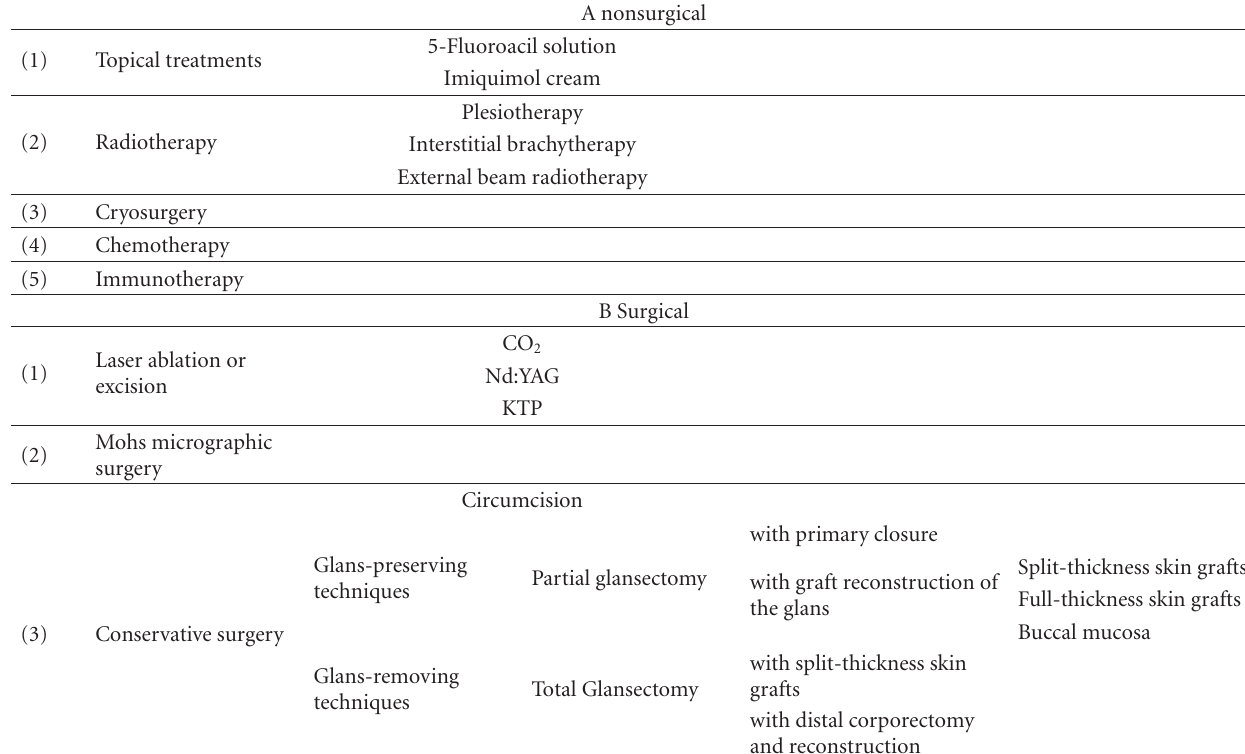
Table 2: Organ-preserving therapeutic strategies for penile